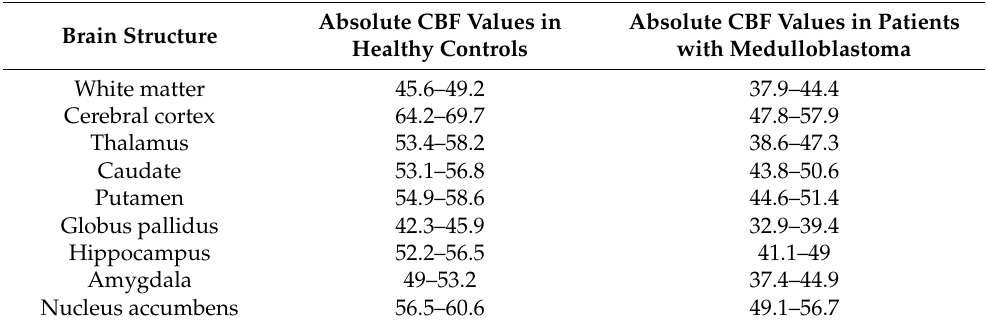
Table 9. Absolute CBF values (mL/100 g/min) in patients treated for medulloblastomas and neuro- logically normal children